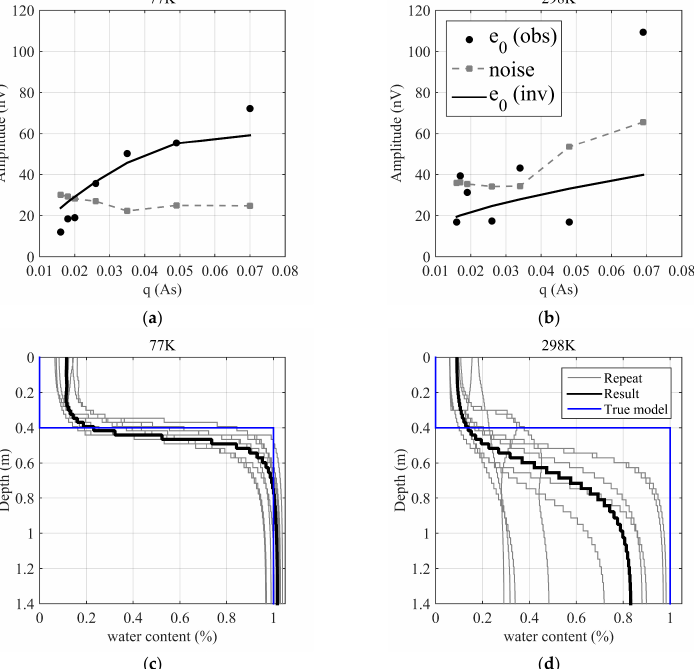
Figure 13. Initial amplitude curves to pulse moment and inversion results. In subgraphs ( a , b ), black circles are the initial amplitudes e 0 extracted from measured data. Black solid curves are the initial amplitudes e 0 calculated from the inversion results. Gray squares are ambient noise estimated from the measured data. In subgraphs ( c , d ), gray curves are the repeated inversion results. Black curves are the inversion results. Blue curves are the true model. ( a ) e 0 − q and noise at 77 K; ( b ) e 0 − q and noise at 298 K; ( c ) inversion results at 77 K; ( d ) inversion results at 298 For the kernel calculation, the mesh is generated and the magnetic field is also calculated based on the finite element method using a commercial software, COMSOL Multiphysics. For the inversion, the initial model is a homogeneous aquifer form 0–1.4 m with the water content of 10%. The regularization is chosen to fit the measured data within the range of data err, i.e., applying the discrepancy principle. For the inversion at 298 K, the results are significantly different from the true model because the SNR is low. The water surface position is unclear, and the water content gradually increases from 0.4 m to 1 m with a maximum water content of 80%, which is lower than